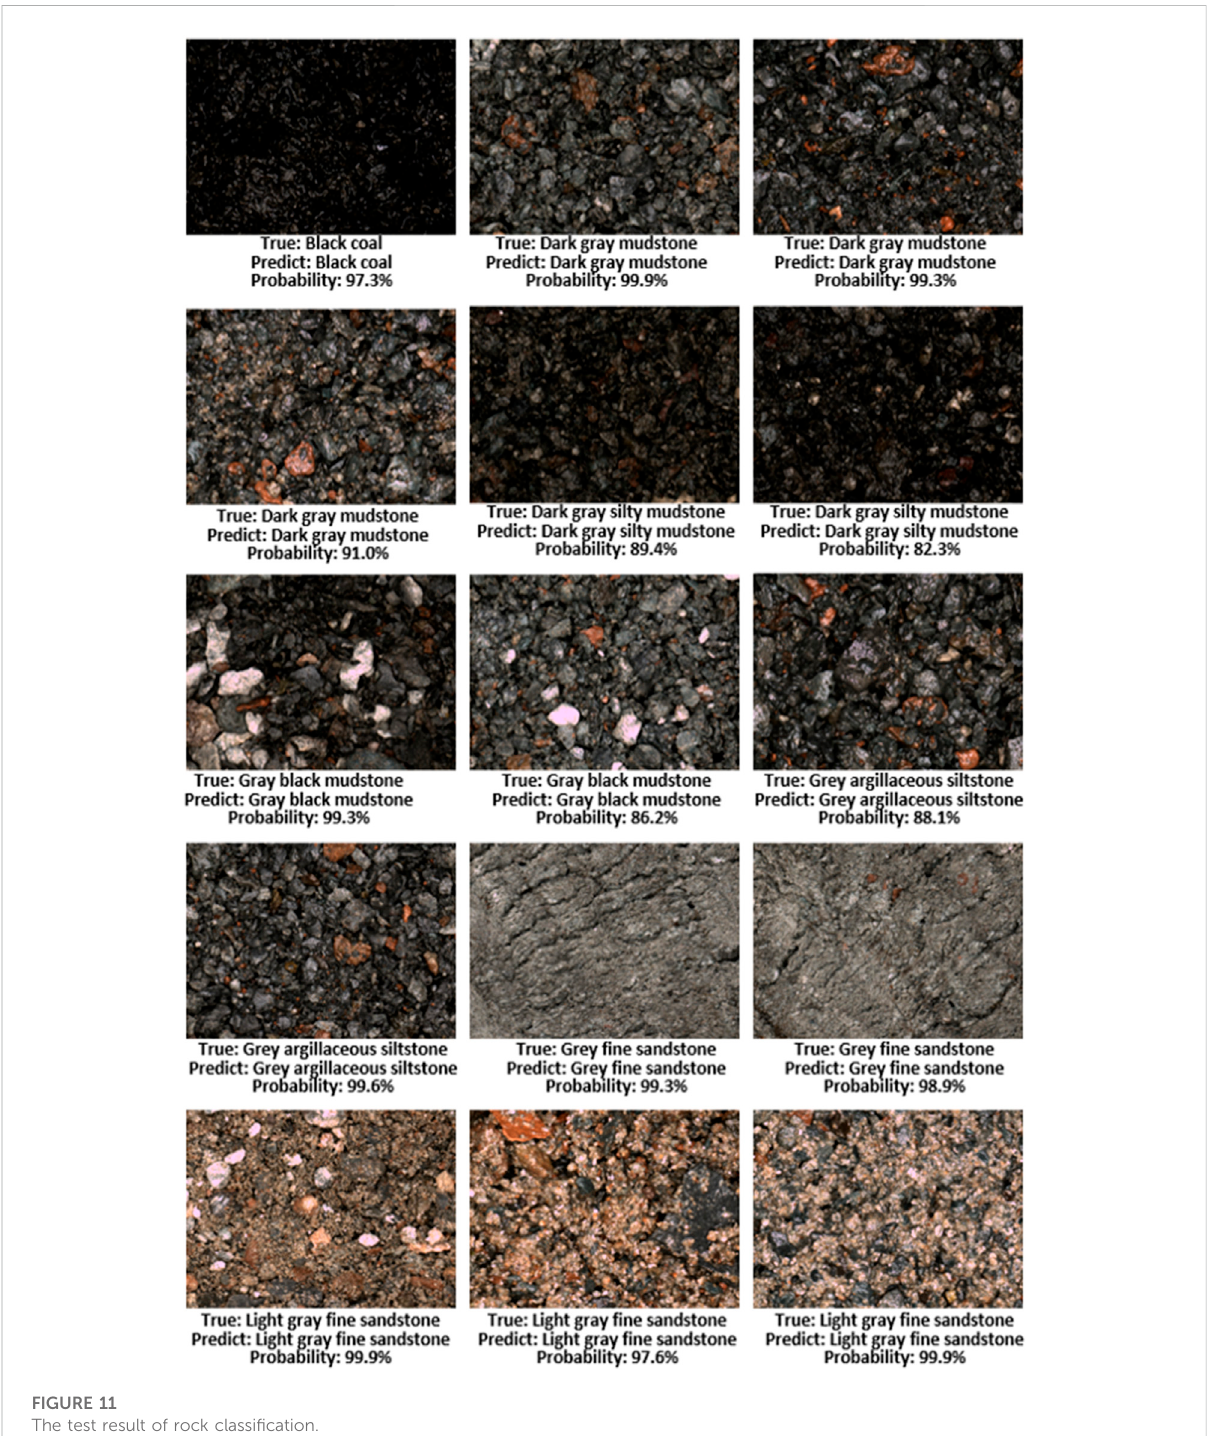
FIGURE 11 The test result of rock classi fi